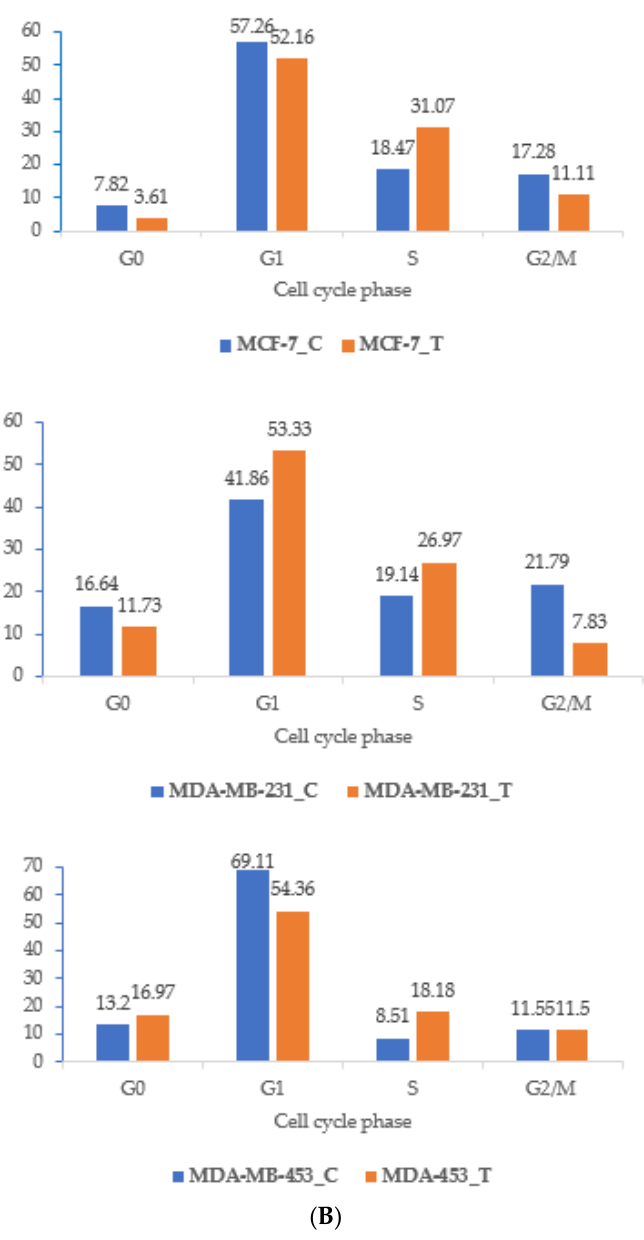
Figure 1. Cell cycle analysis ( A ) The cell cycle of the breast cancer cell lines MCF ‐ 7, MDA ‐ MB ‐ 231, and MDA ‐ MB ‐ 453 were analyzed using flow cytometry on the control and the SKACP003treated cell lines. ( B ) The ratio of cells in the G0, G1, S, and G2/M cell cycle phases in the control and the SKACP003 ‐ treated MCF ‐ 7, MDA ‐ MB ‐ 231, and MDA ‐ MB ‐ 453 cell lines. SKACP003-treated MCF-7, MDA-MB-231, and MDA-MB-453 cell